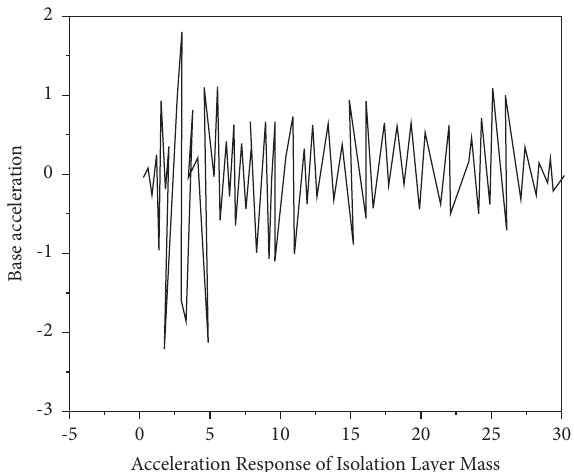
Figure 2: El Centro seismic wave excitation acceleration and response acceleration.